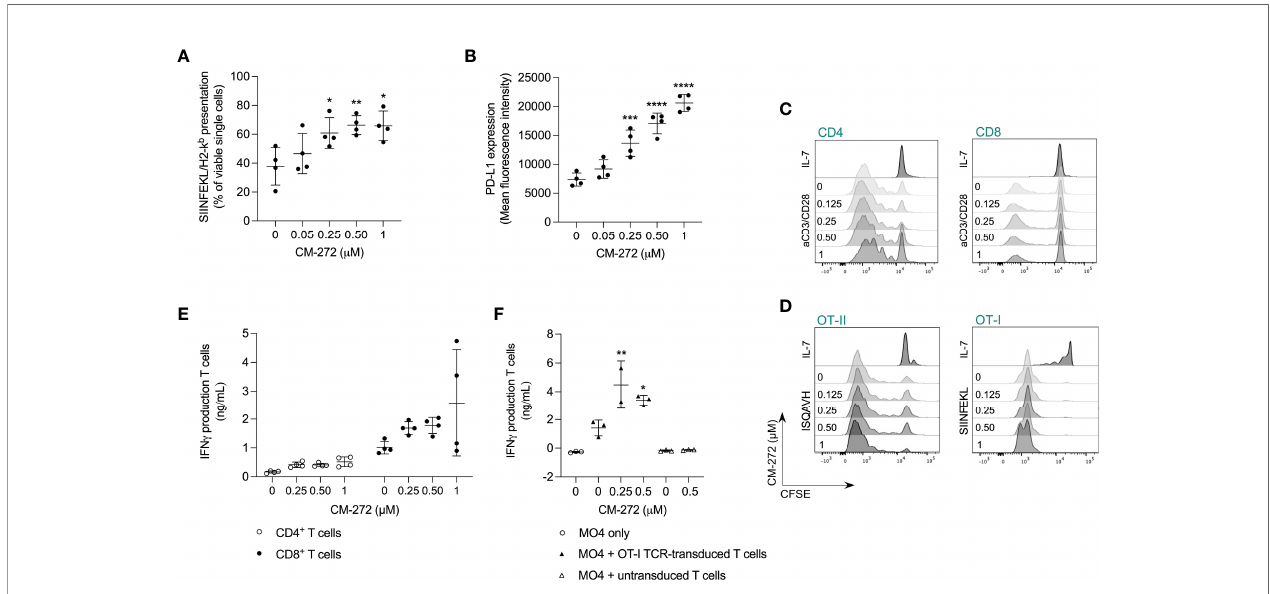
FIGURE 3 | Dual G9a and DNMT inhibition favors tumor cell recognition by tumor-speci fi c T cells in vitro. (A, B) MO4 cell surface presentation of (A) SIINFEKL/H2- K b or (B) PD-L1 after CM-272 treatment for 24 hours (mean ± SD; n = 4). (C, D) T-cell proliferation upon 72 hours of polyclonal (anti-CD3/CD28) or peptide (SIINFEKL/ISQAVH) stimulation of (C) CD4 + and CD8 + T cells or (D) OT-I and OT-II T cells, respectively, in the presence or not of CM-272 (representative histograms; n =4 [B]/ n =2 [C]). (E, F) IFN- g production upon 48 hours of (E) polyclonal stimulation of T cells (mean ± SD; n = 2, total 4 s.p.c.) or (F) MO4-mediated stimulation of (un)transduced T cells (mean ± SD; n =2/3). Vehicle and CM-272 conditions were compared using ordinary one-way Anova and post-hoc Dunnett ’ s multiple comparison test (A,B,F). Asterisks indicate statistical signi fi cance: *p ≤ 0.05; **p ≤ 0.01; ***p ≤ 0.001; ****p ≤